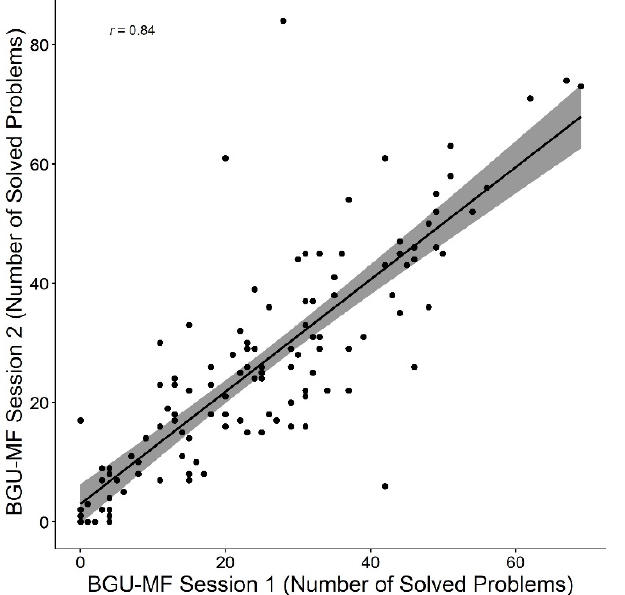
Figure 2. Correlation between number of solved problems in the first and second sessions in the BGU ‐ MF.